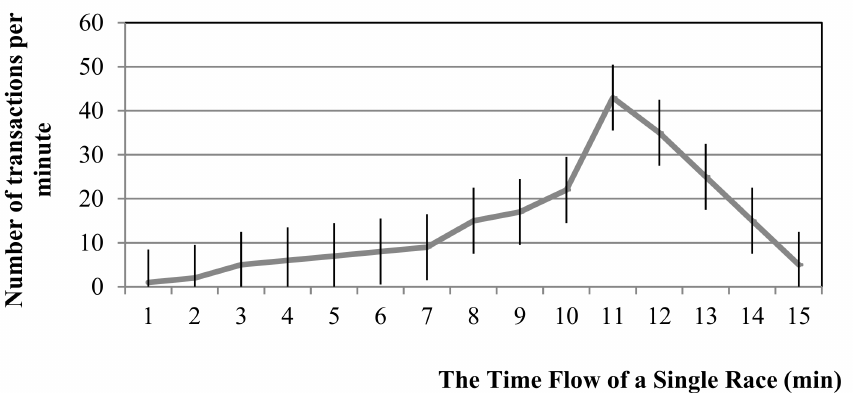
Figure 4. SafeZone using a fixed